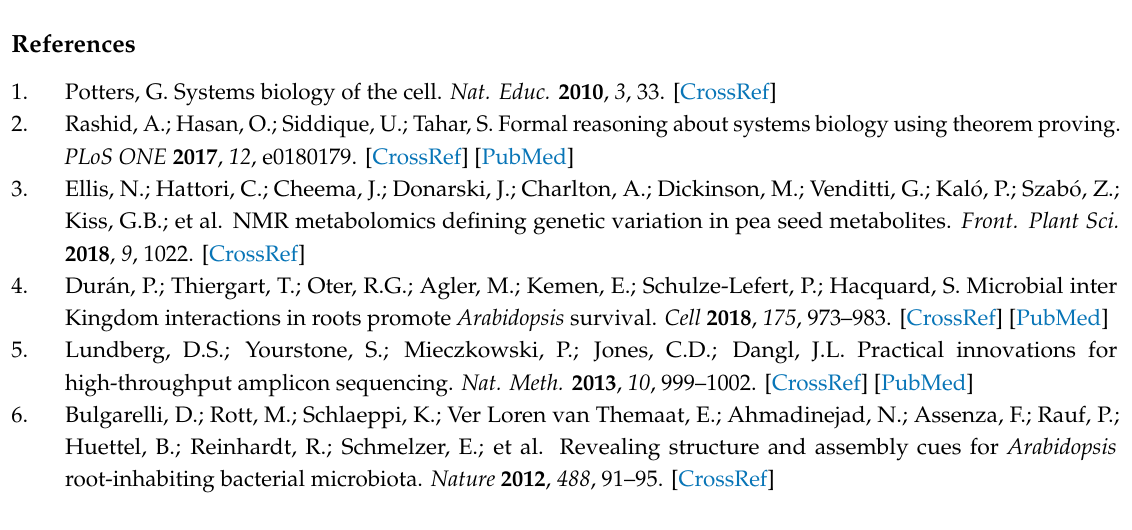
Table S1: Facts about fungal diseases and molds as potential risks for Cannabis sativa product quality and safety for human